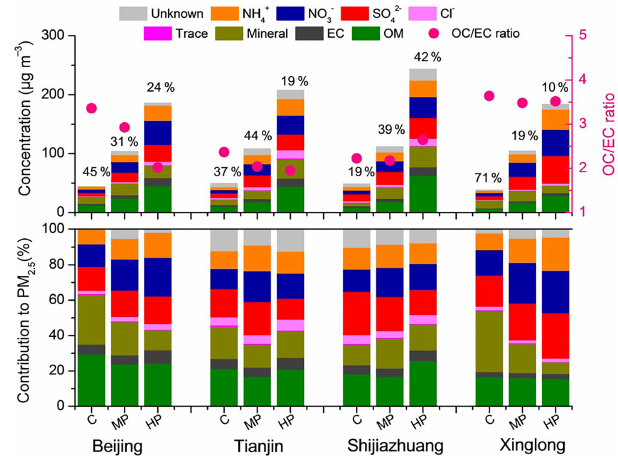
Figure 7. The evolution of aerosol chemical species and the OC / EC mass ratio (marked with pink dots) at different pollu- tion levels during the entire observational period. C, MP, and HP represent clean days (PM 2 . 5 < 75µgm − 3 ) , moderate pollu- tion days (75 ≤ PM 2 . 5 < 150µgm − 3 ) , and heavy pollution days (PM 2 . 5 ≥ 150µgm − 3 ) , respectively; “%” represents the proportion of the filter sample quantity at each pollution level out of the total